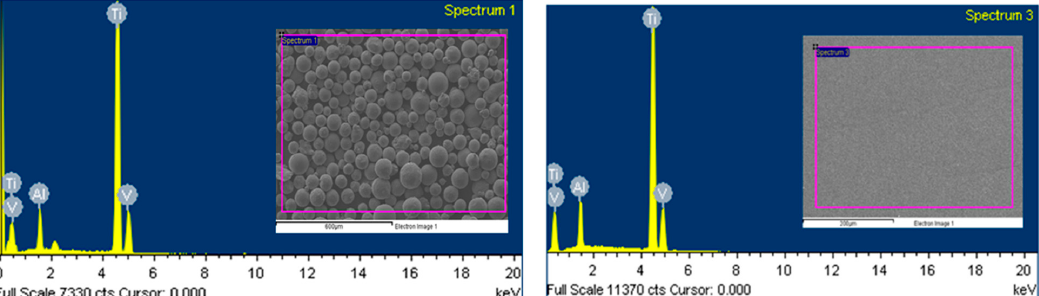
Figure 11. Chemical composition of the Ti6Al4V ELI feedstock powder ( left ) and EBM-fabricated specimen ( right ) obtained through EDS Test. Table 1. Chemical specifications of the ASTM Standards, feedstock powder and EBM-fabricated specimen (wt. %) of Ti6Al4V ELI material.